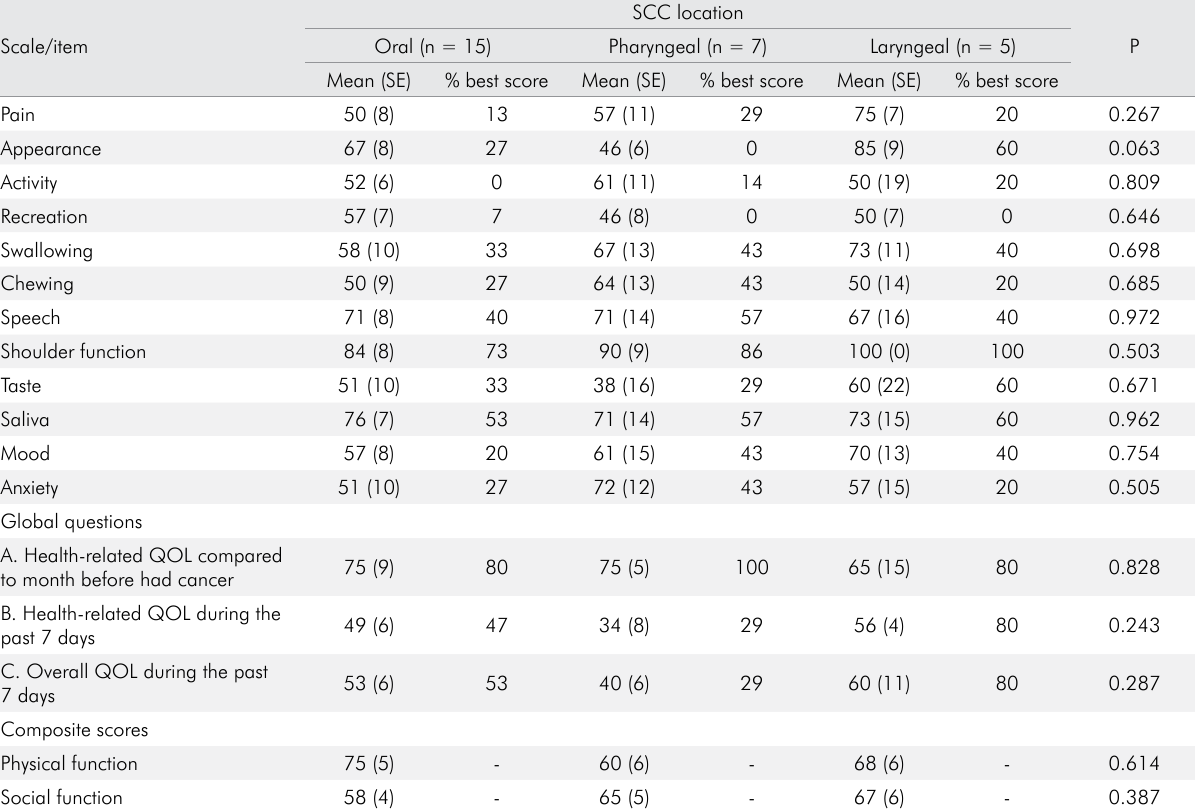
Table 3. UW-QOL scores according to tumor